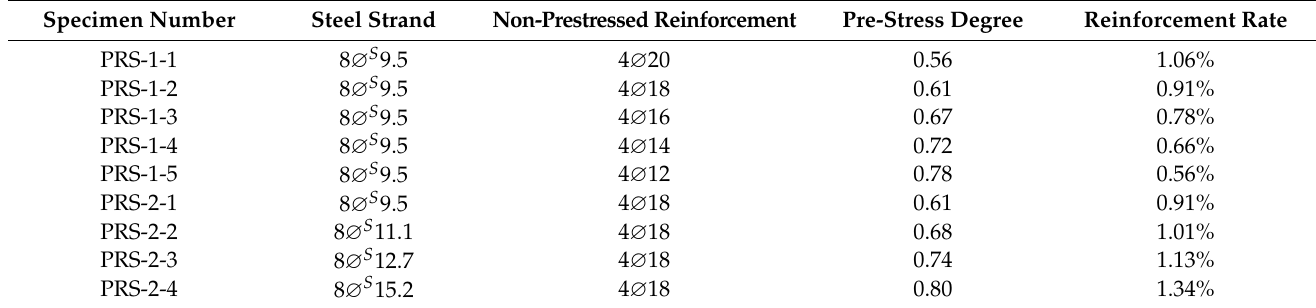
Table 6. Numbers and parameters of